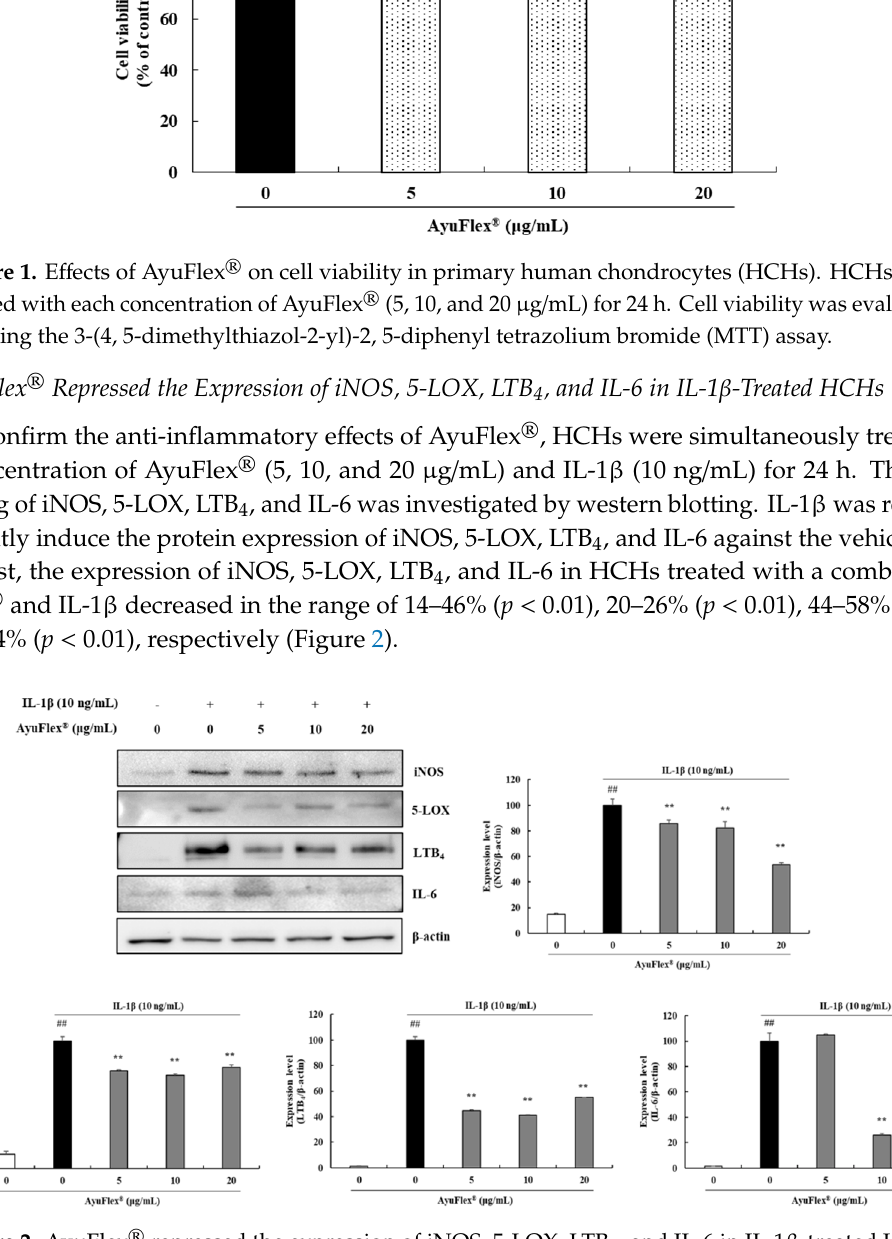
Figure 2. AyuFlex ® repressed the expression of iNOS, 5-LOX, LTB 4 , and IL-6 in IL-1 β -treated HCHs. HCHs were treated with IL-1 β (10 ng/mL) single or in combination with AyuFlex ® (5, 10, and 20 μ g/mL) for 24 h. Effects of AyuFlex ® on the expression of iNOS (135 kDa), 5-LOX (78 kDa), LTB 4 (36 kDa), and IL-6 (25 kDa) in IL-1 β -treated HCHs were analyzed. Protein bands were quantified utilizing ImageJ. As a control for normalization, β -actin was utilized. ## p < 0.01, in comparison with the vehicle control group. ** p < 0.01, in comparison with the IL-1 β -treated control group.